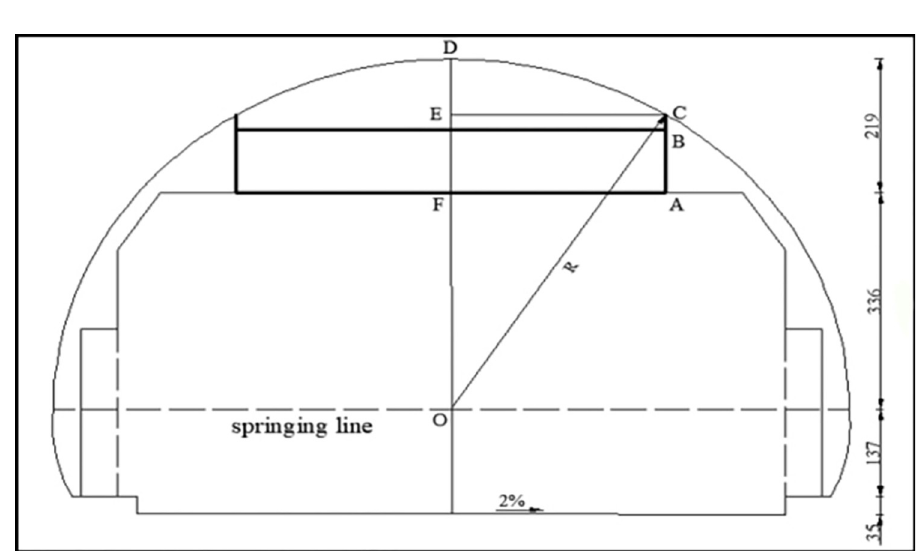
Fig 3. Inner contour drawing of one-way, two-lane highway tunnel.